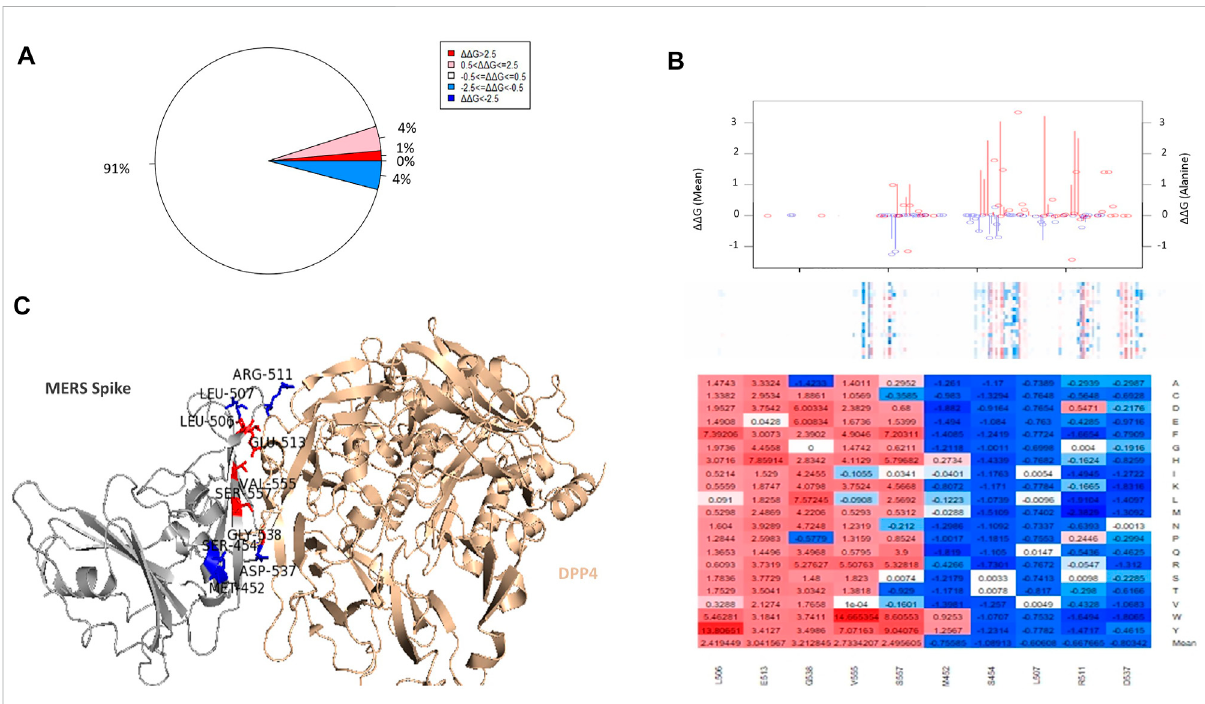
FIGURE 4 (A) Percentages of ΔΔΔ G values that represent increased or decreased binding af fi nity in the MERS-CoV S RBD. (B) The energy landscape with respect to binding af fi nity. The af fi nity heatmap is depicted below. And the chart at the bottom displays the ΔΔΔ G values for the top stabilizing and destabilizing residues. (C) Picture displays the position in the MERS-CoV S RBD with respect to binding af fi